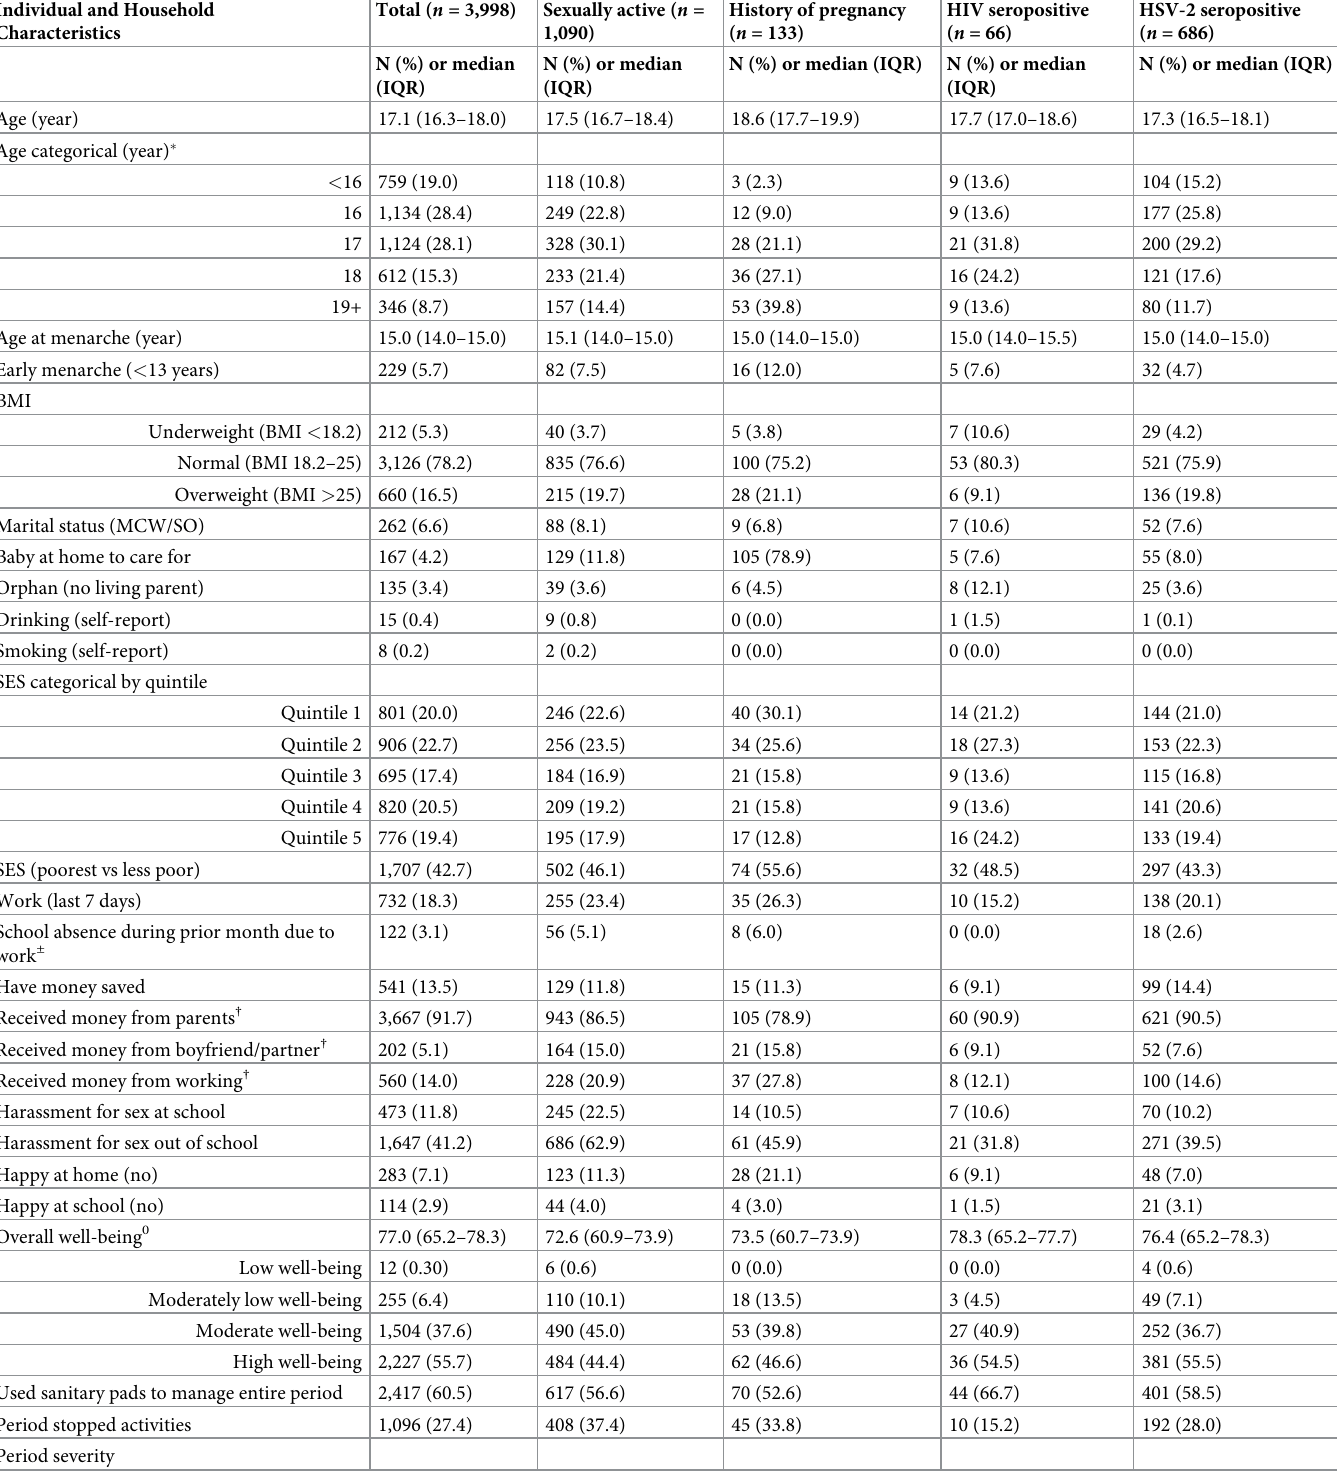
Table 1. Individual and household characteristics by SRH status among 3,998 adolescent girls attending secondary school, Siaya County, western Kenya, 2017– 2018. Individual and Household